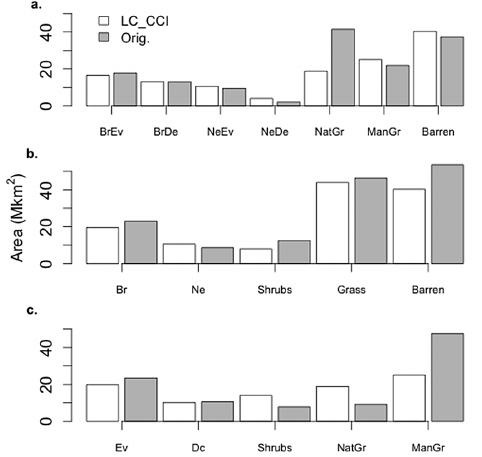
Figure 4. Global PFT coverage comparing the LC_CCI and original data sets for (a) ORCHIDEE, (b) JULES and (c) JSBACH. Where “Br” is broadleaf, “Ne” is needleleaf, “Ev” is evergreen, “De” is de- ciduous, “ManGr” is managed grassland, “NatGr” is natural grass- land and “barren” includes bare soil or ice. Note JSBACH has no bare soil category.